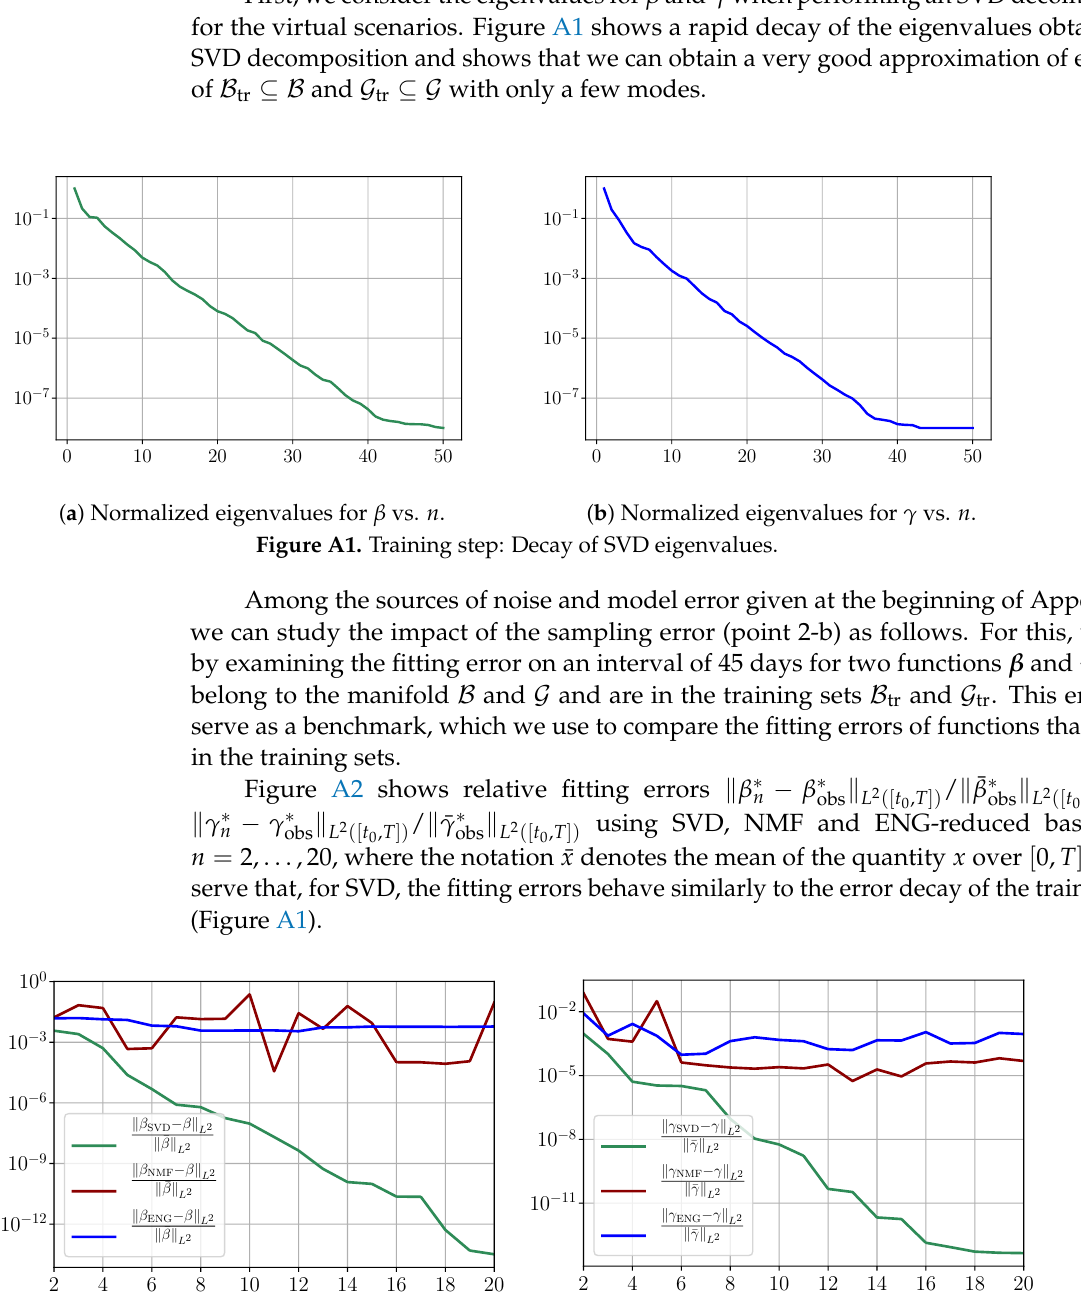
Figure A2. Study of sampling errors: Fitting errors of functions β and γ from and G tr